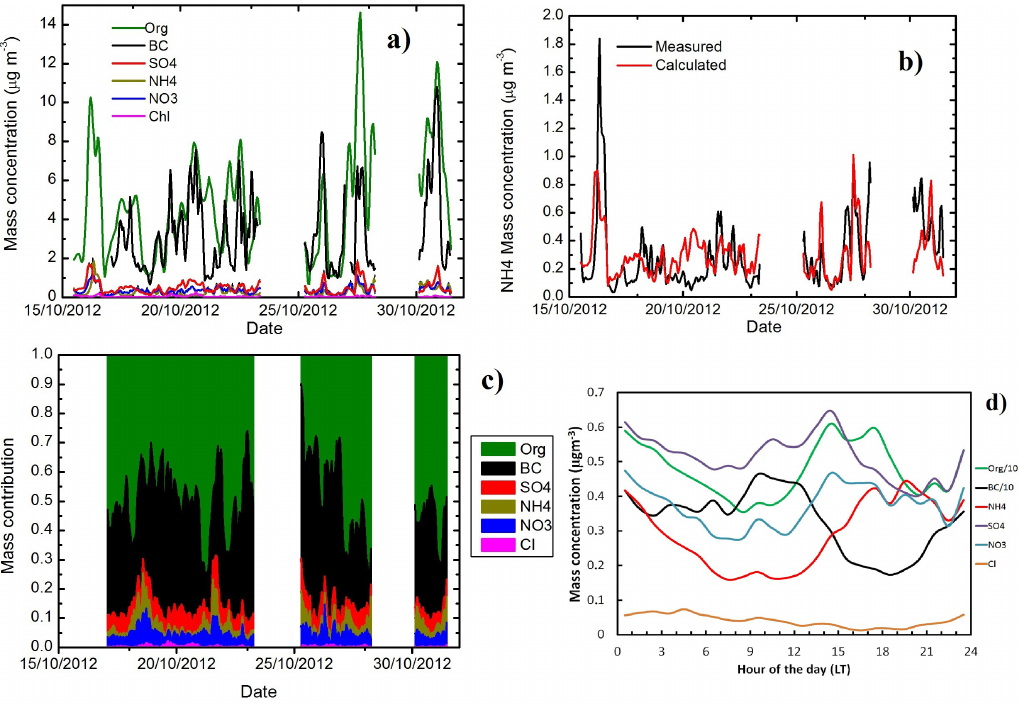
Figure 4. Chemical composition of the aerosol, measured by the ACSM and the MAAP. (a) Mass concentration of the individual species; (b) mass concentration of the measured NH 4 and the calculated amount needed for complete neutralization; (c) the mass fractions of the organics, NH 4 , NO 3 , SO 4 and black carbon; and (d) the mean aerosol chemical composition as a function of local time.